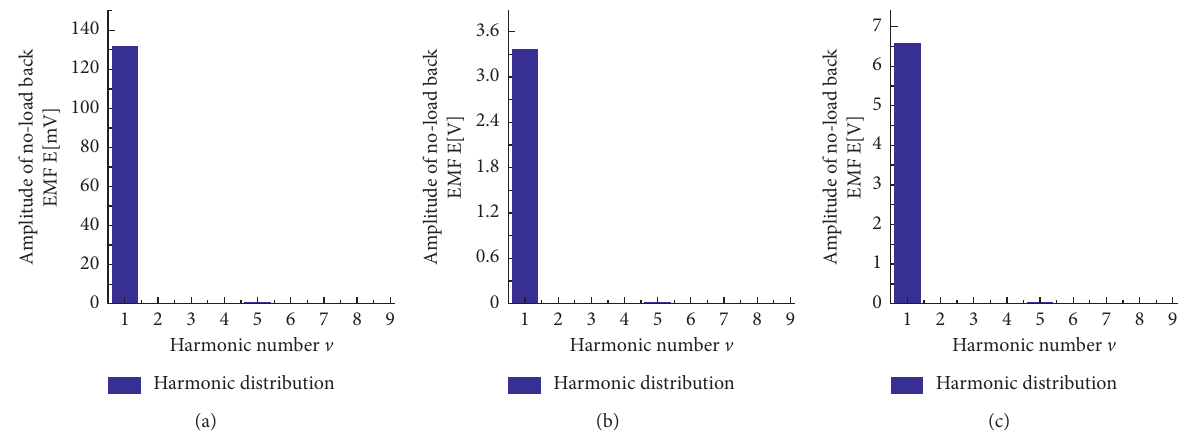
Figure 23: Harmonic analysis diagram of motor back EMF at different speeds: (a) v � 0.02m/s; (b) v � 0.6 m/s; (c) v �